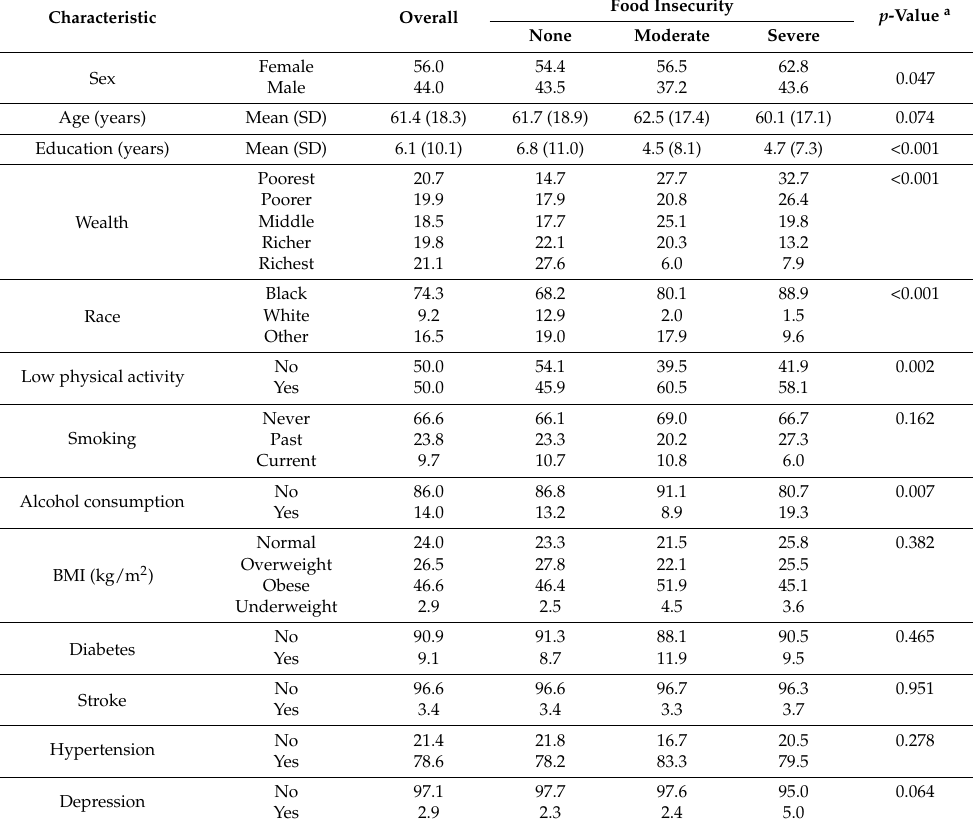
Table 1. Sample characteristics (overall and by food insecurity).